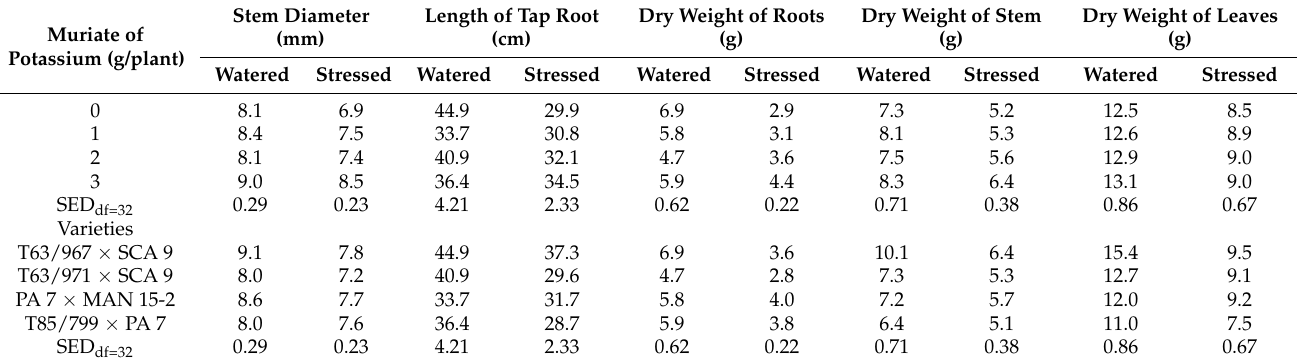
Table 3. Allometric relationships of four cocoa seedling varieties as influenced by watering regime and potassium treatments, 55 days after water stress imposition in experiment 1.